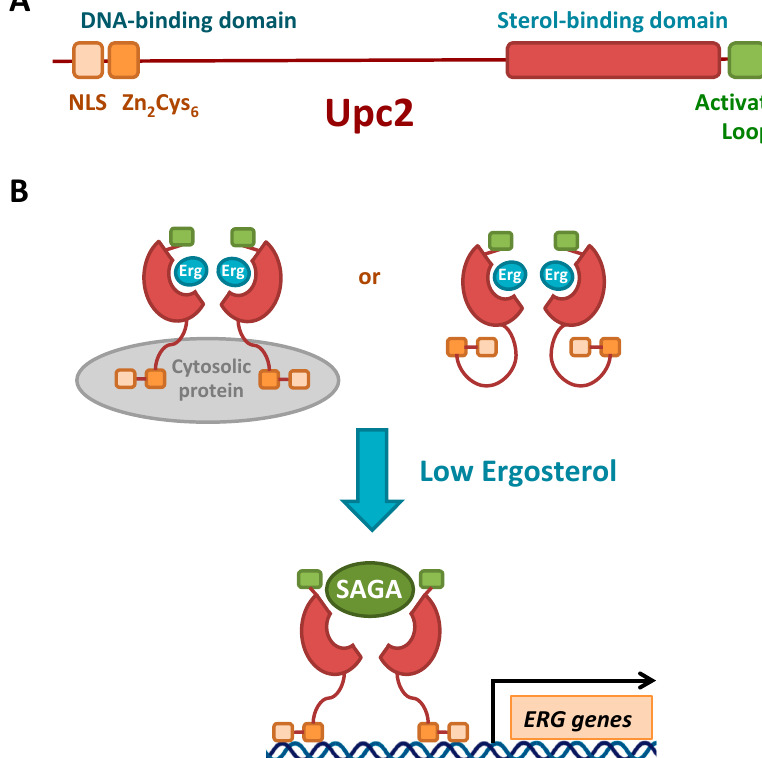
Figure 2. Structure and regulation of the S. cerevisiae Upc2 transcriptional factor. ( A ) Schematic representation of the primary structure of yeast Upc2 protein. NLS, nuclear localization signal. ( B ) Proposed model for the transcriptional regulation of Upc2. Under high-sterol conditions, Upc2 associates to ergosterol (Erg) and localizes to the cytosol. Although the mechanism is currently unknown, it has been proposed that Upc2 stays in the cytosol either because it interacts with a cytosolic protein or because its NLS is not available for nuclear import. Upon sterol depletion, ergosterol-free Upc2 undergoes a conformational change that allows its import to the nucleus, where it binds to ERG gene promoters to activate their transcription through the recruitment of a co-activator, probably the SAGA